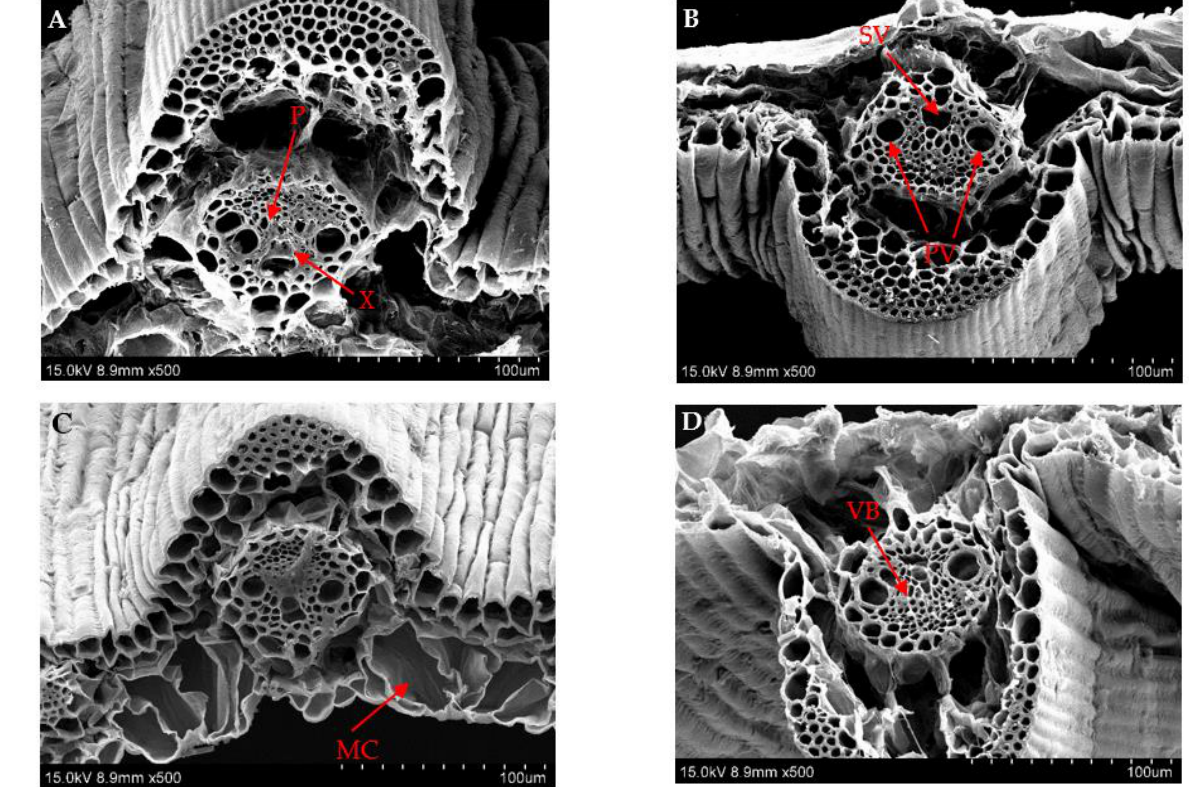
Figure 6. Leaf primary vein crosscutting structures of Kentucky bluegrass ramets in different patches under different water treatments (500×). ( A ) Homogeneous NS+ patch; ( B ) heterogeneous NS+ patch; ( C ) heterogeneous NS− patch; ( D ) homogeneous NS− patch; VB: vascular bundle; P: phloem; X: xylem; PV: pitted vessel; SV: spiral vessel; MC: motor cell.